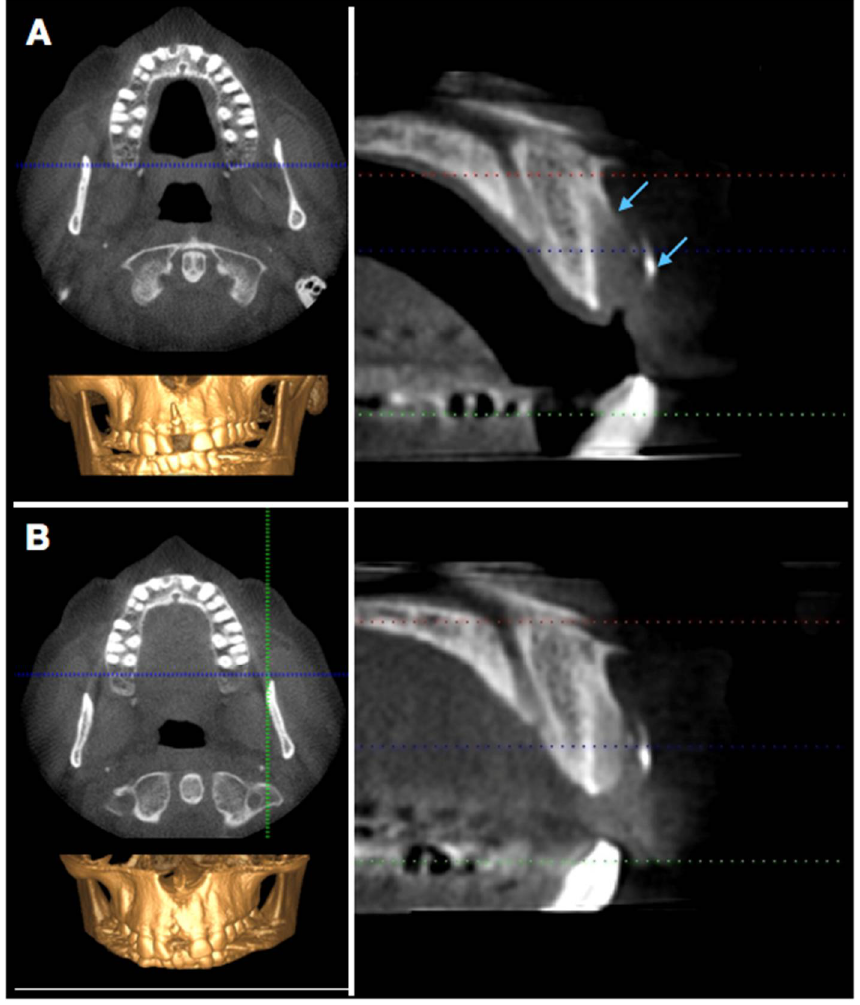
Figure 6. Radiographic evaluation (CBCT) after 6 ( A ) and 16 ( B ) weeks. The arrows in panel ( A ) indicate the border of the buccal bone plate and the radiopaque membrane.